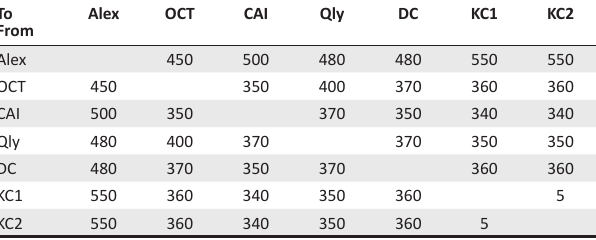
TABLE 3: Transportation cost matrix for common